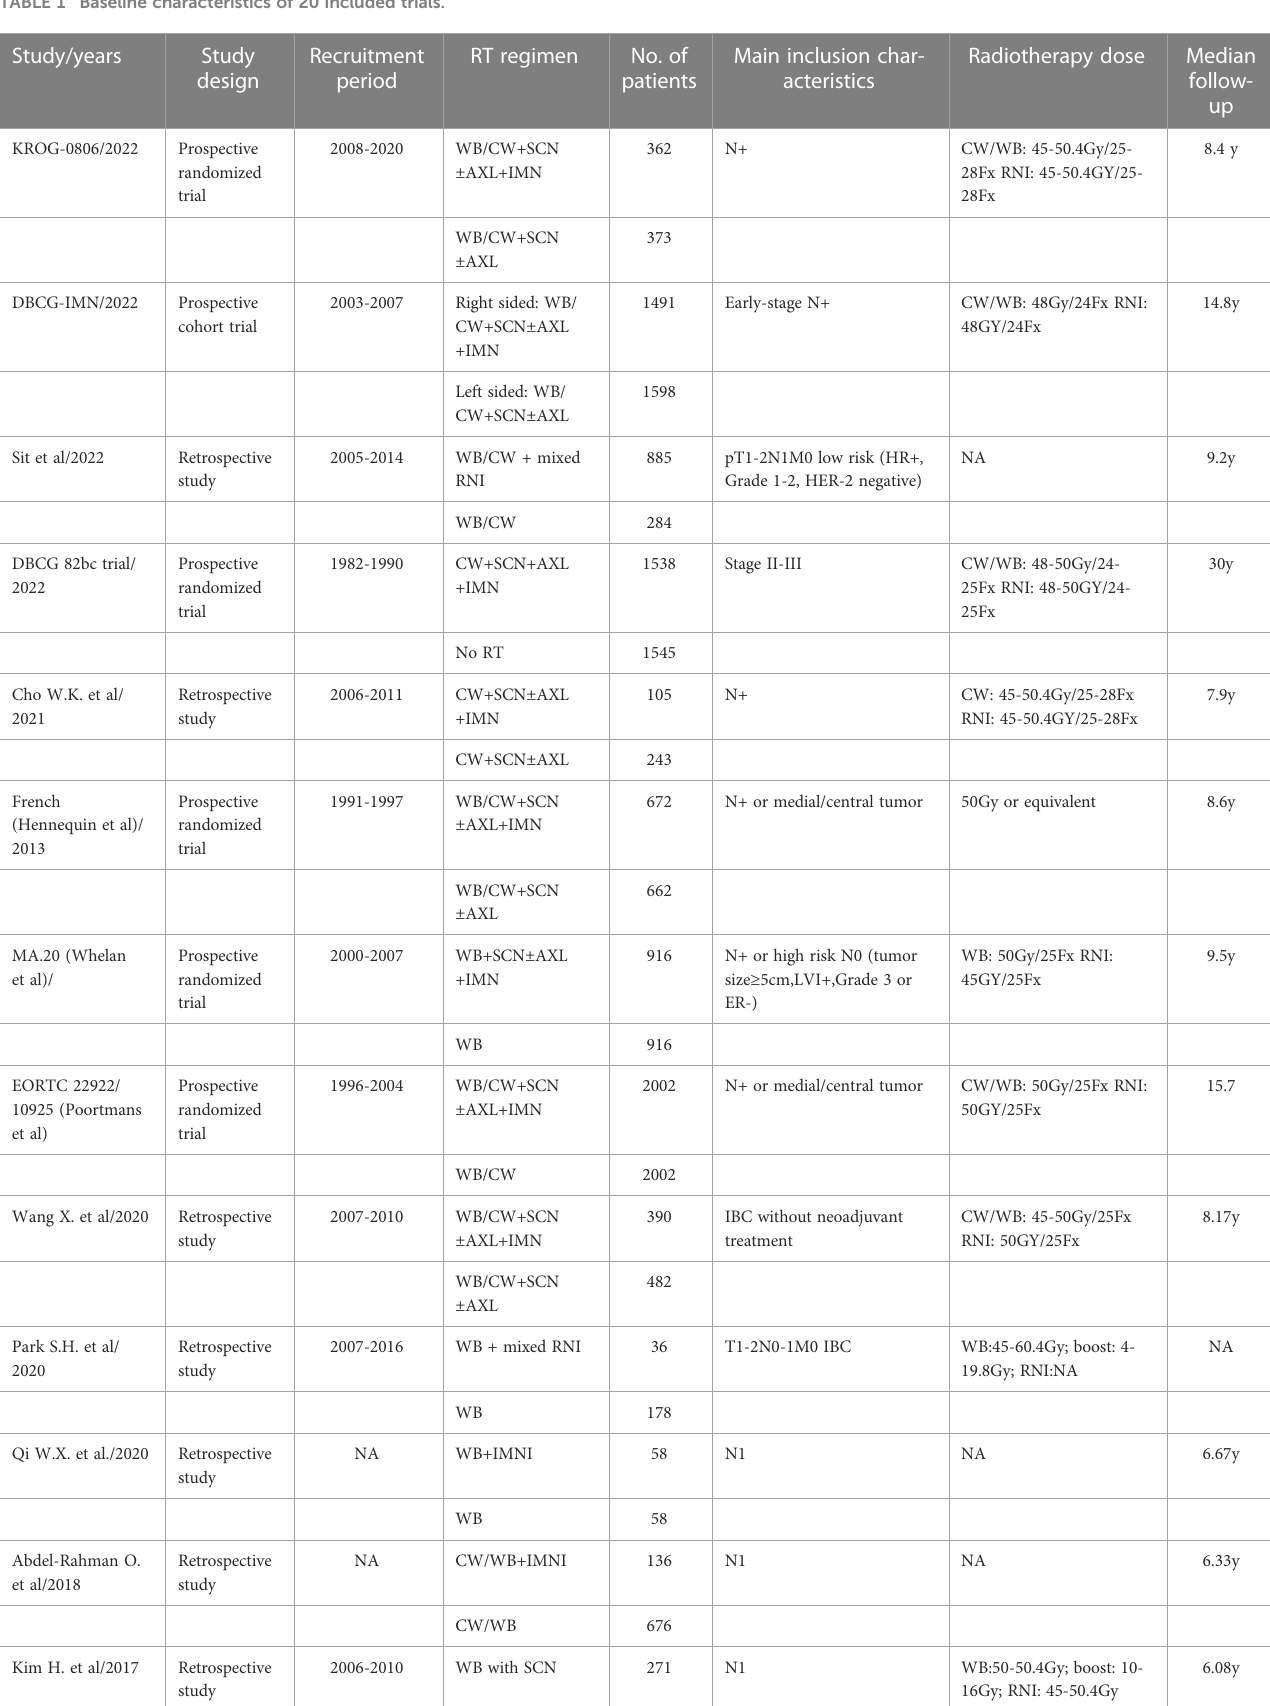
TABLE 1 Baseline characteristics of 20 included